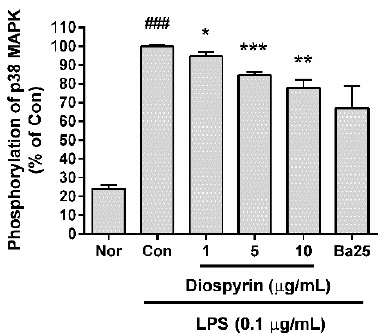
Figure 5. Effect of diospyrin on the phosphorylation of p38 MAPK in LPS-induced RAW 264.7 cells. After 15 min of treatment, the phosphorylation of p38 MAPK was measured via flow cytometry. The normal group (Nor) was treated with media only. The control group (Con) was treated with LPS (0.1 µ g / mL) alone. Ba25 denotes baicalein (25 µ M). Values are the mean ± SD of three independent experiments. ### p < 0.001 vs. Nor; * p < 0.05 vs. Con; ** p < 0.01 vs. Con; *** p < 0.001 vs. Con.